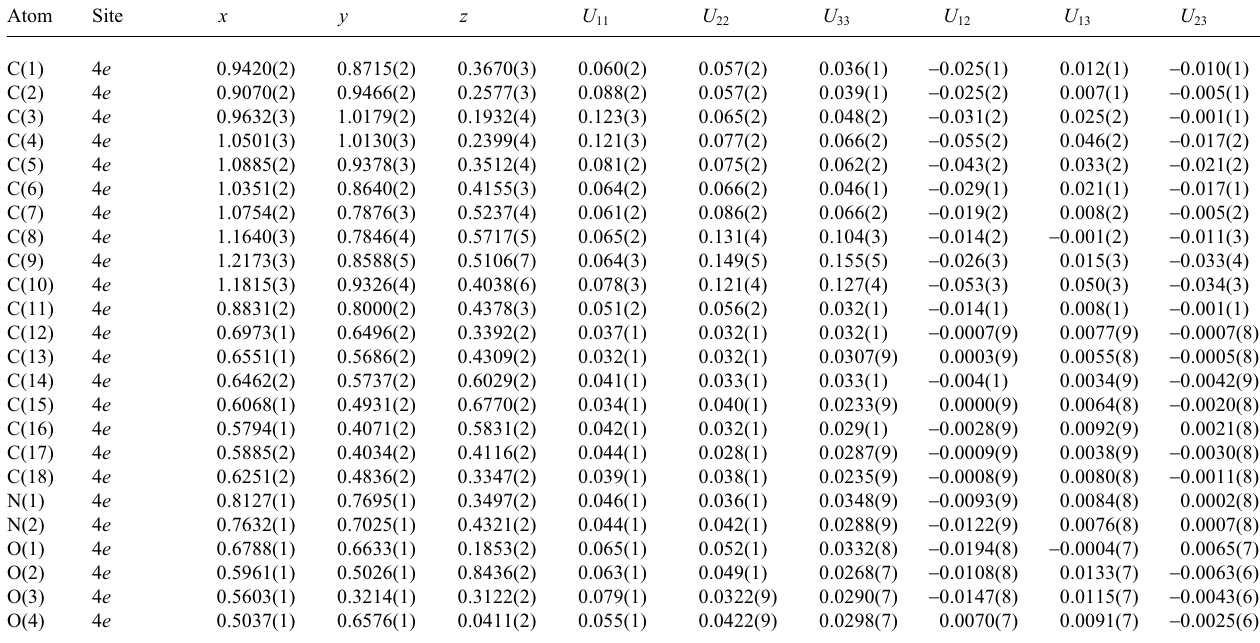
Table 3. Atomic coordinates and displacement parameters (in Å 2